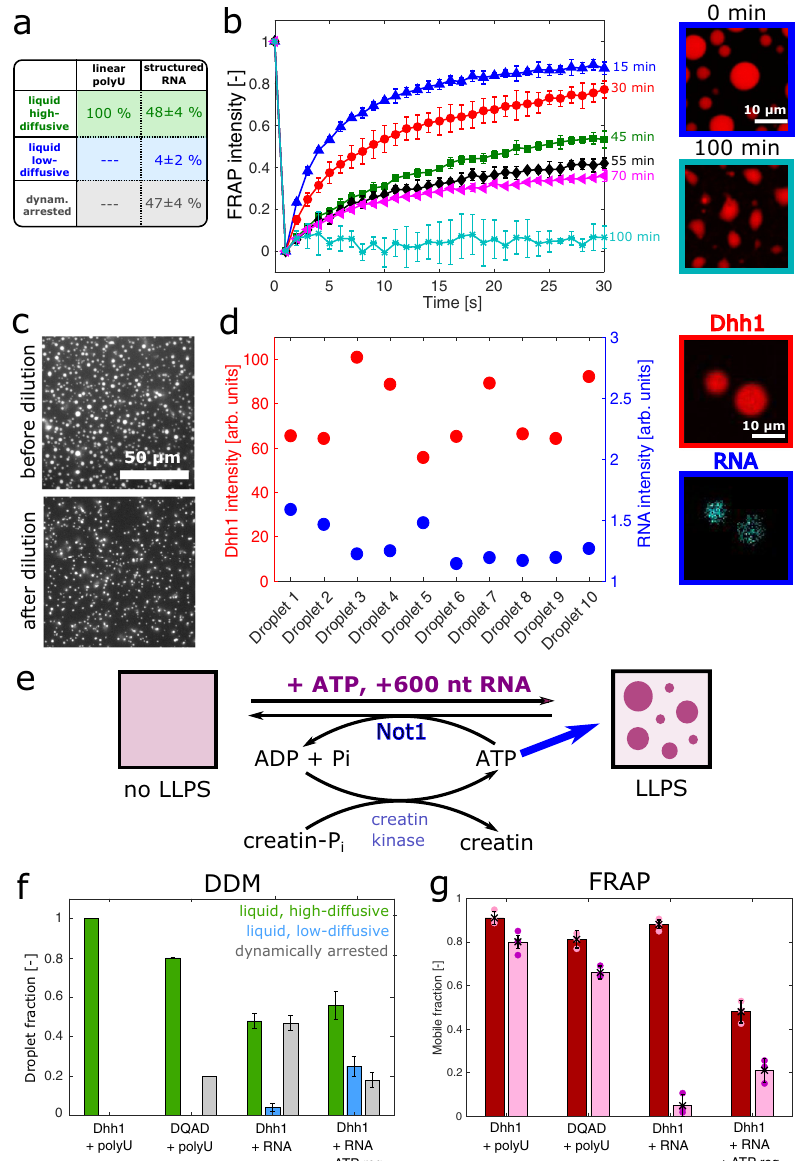
Fig. 6 Effect of structured RNA on the dynamics of the condensates. a The addition of 0.05 mg/ml structured RNA (600 nucleotides) to a solution of 11 µ M full-length Dhh1 and 5 mM ATP/MgCl 2 lead to the formation of droplets with a high fraction (47 ± 4%) of glass-/gel-like droplets, in contrast with droplets formed in presence of polyU (0%). b Fluorescence recovery after photobleaching (FRAP) measurements showed a decrease in the mean recovery of three different droplets over a time course of 100 min. Simultaneously, the morphology of the droplets changed from an initially spherical to an irregular shape. Error bars represent the standard deviation of FRAP signals of three different droplets. c Condensates formed in presence of structural RNA cannot be dissolved by dilution. d Different droplets imaged by using confocal microscopy at the same time point exhibited different values of mCherry-tagged Dhh1 and Fluorescein-12-labeled RNA intensities. Intensity values represent the whole droplet mean intensity of individual droplets. e Effect of droplet turnover on material properties of biomolecular condensates. Schematic illustration of the ATP-hydrolysis-regeneration system. f Fractions of the different droplet subpopulations characterized by DDM over 100 min of incubation: high-diffusive liquid (green), low-diffusive liquid (blue), and dynamically arrested (gray). Error bars represent the standard error of the mean of at least 15 different droplets per condition. g Mean mobile fraction extracted from FRAP measurements at time 0 (dark red) and after 100 min incubation (light red). In presence of polyU, the mobile fraction was about 91 ± 3% and remains almost constant over time. A similar behavior was observed for the Dhh1 DQAD variant. When polyU was replaced with structured RNA, the mobile fraction decreased to 5 ± 5% over time, and this decrease could be partially rescued when coupled to an active system. Error bars represent standard deviation of mobile fractions of three different droplets. Source data for panels b , d , f , g are provided in the Source Data fi